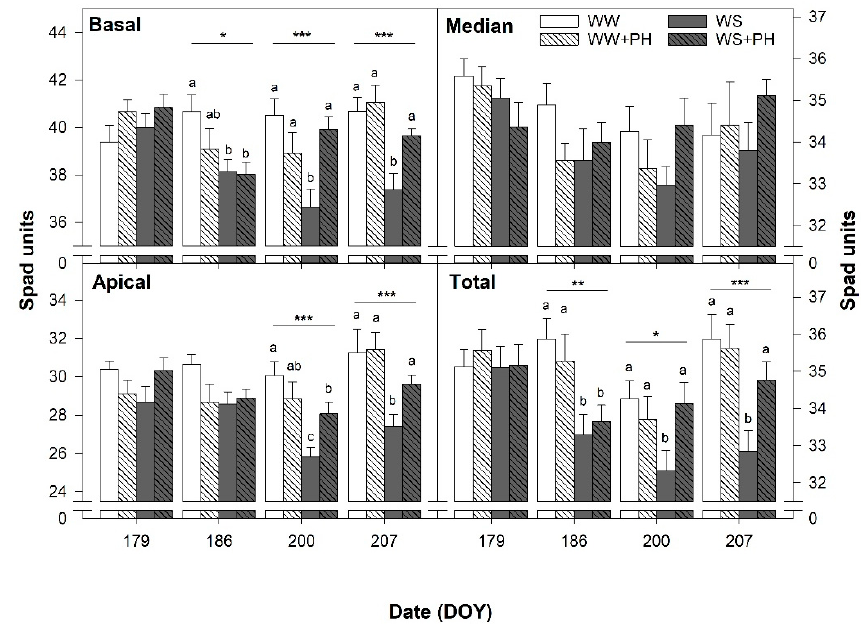
Figure 5. Effects of water stress (WS) compared with well-watered conditions (WW) and PH application, on the leaf chlorophyll content of basal, median, apical, and all (total) leaves measured as SPAD units before the drought trial (DOY 179), under light (DOY 186) and severe water stress (DOY 200), and upon recovery to well-watered conditions (DOY 207). Means ± SE values indicated with the same letters are not significantly different according to Tukey’s test ( p < 0.0083, p < 0.002 and p < 0.0008 after sequential Bonferroni adjustment for α = 0.05 (*), α = 0.01 (**) and α = 0.005 (***), respectively).